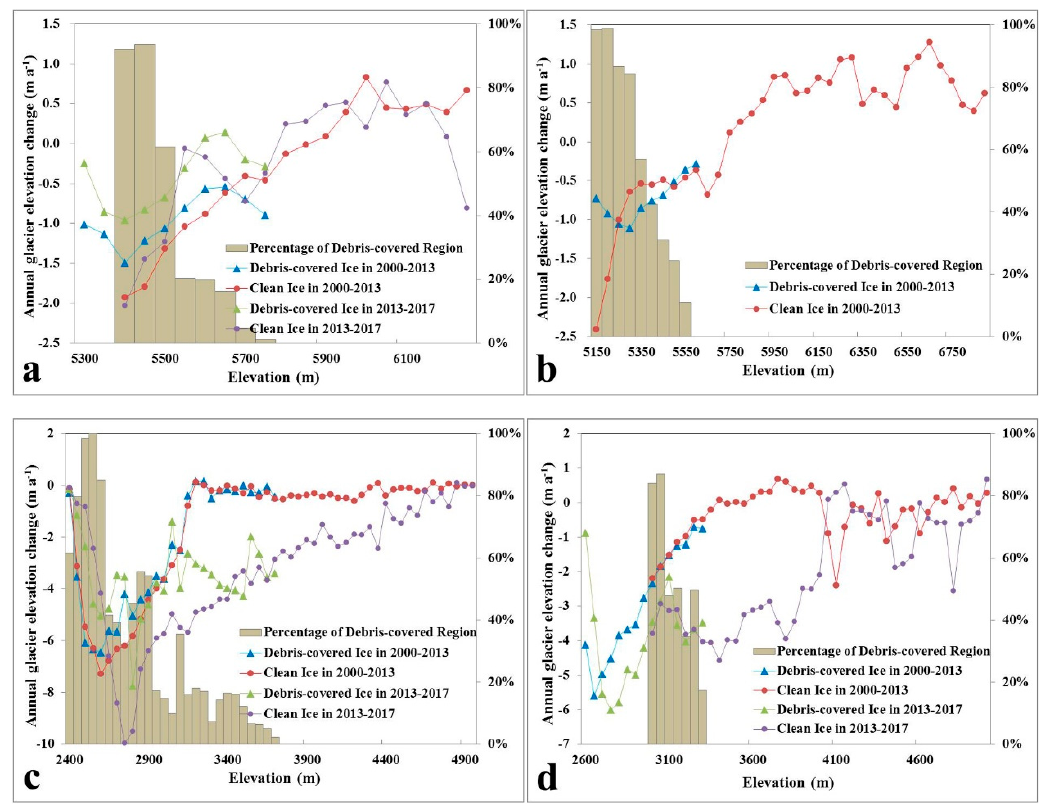
Figure 12. The annual elevation changes of unnamed ( a ), Xibu ( b ), Azha ( c ) and Xueyougu ( d ) in debris-covered and debris-free glaciers during 2000–2013 and 2013–2017. Note: the percentage of debris-covered region was calculated as debris area divided by the total area in each elevation bin.